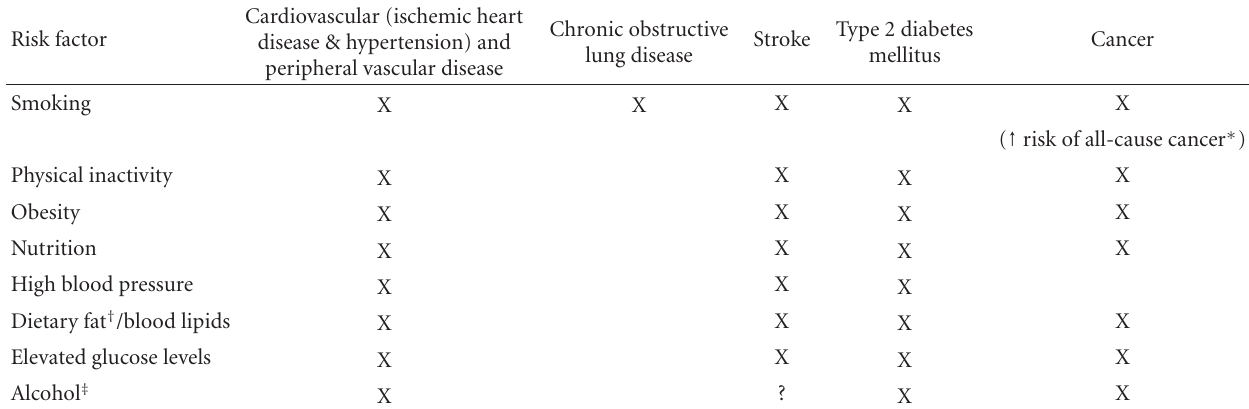
Table 1: Major modifiable risk factors for chronic lifestyle-related